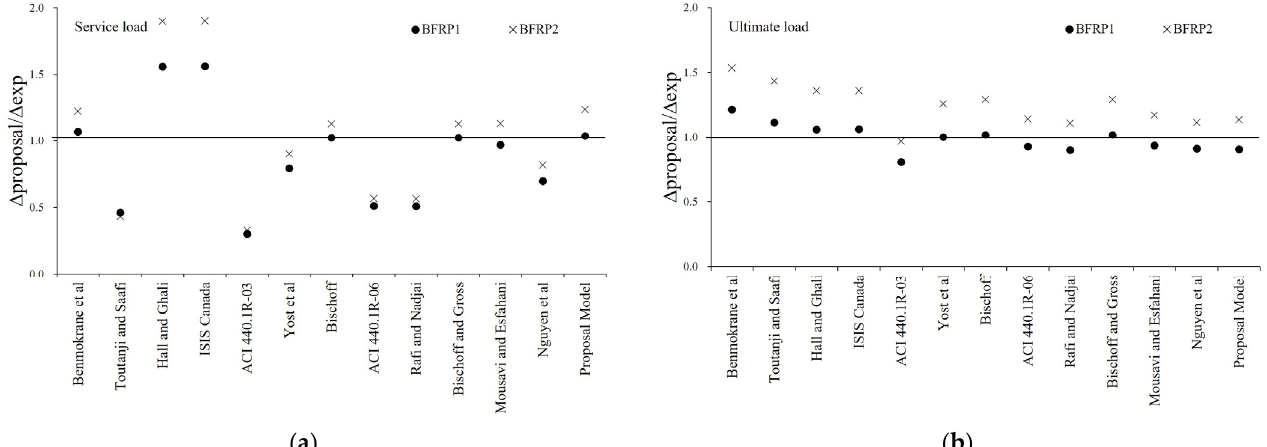
Figure 8. Experimental versus predicted midspan deflection of BFRP Specimens: ( a ) Ratio of experimental and predicted deflection at service load; ( b ) Ratio of experimental and predicted deflection at ultimate load.